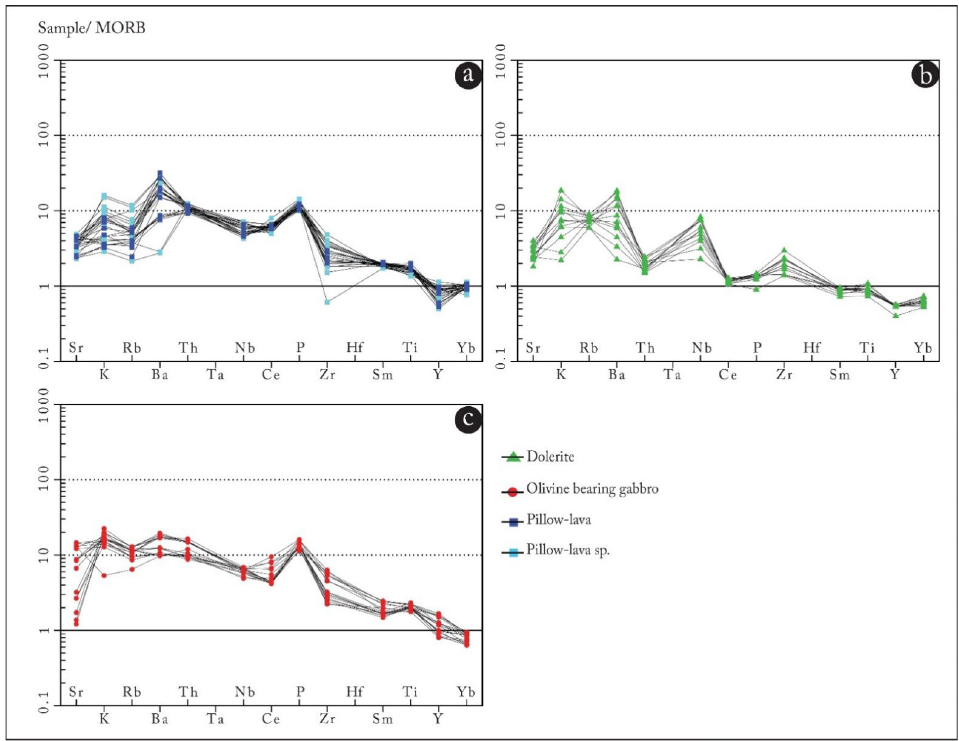
Figure 22. Multielement diagrams normalized to MORB [64] or magmatic rocks of NNE Achemmach. ( a ): Pillow-lavas, ( b ): dolerites, ( c ): Olivine-bearing gabbros.